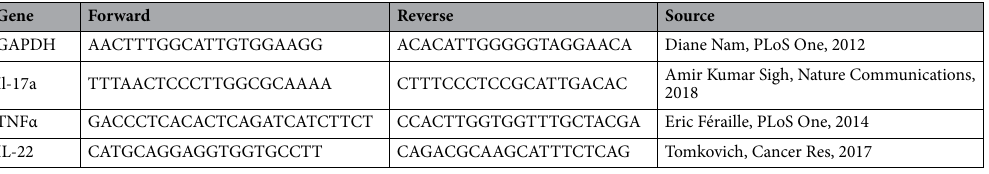
Table 1. List of